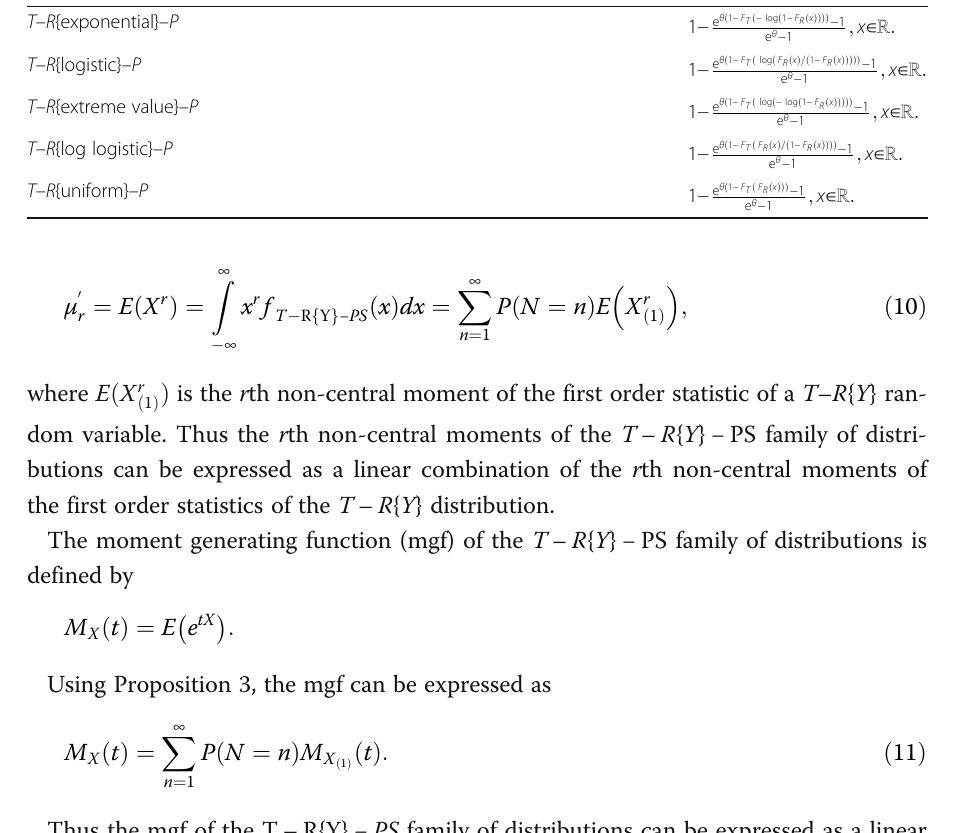
Table 7 Different T – R { Y } – P distributions Distributions